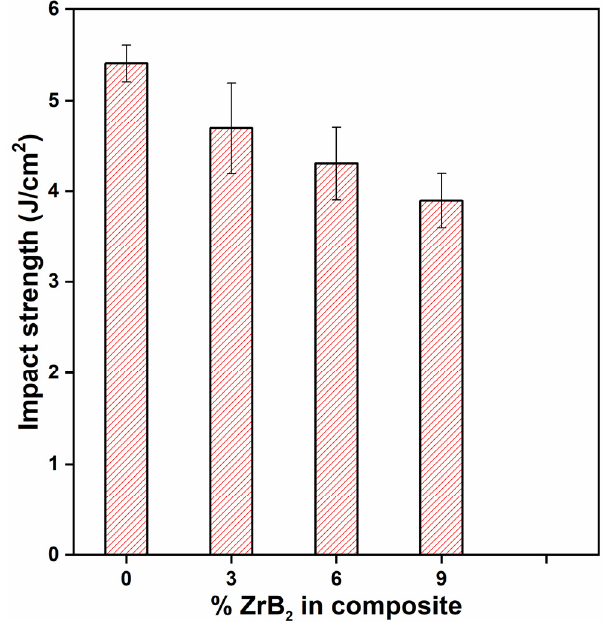
Figure 9. Impact strength of material with reinforcement.